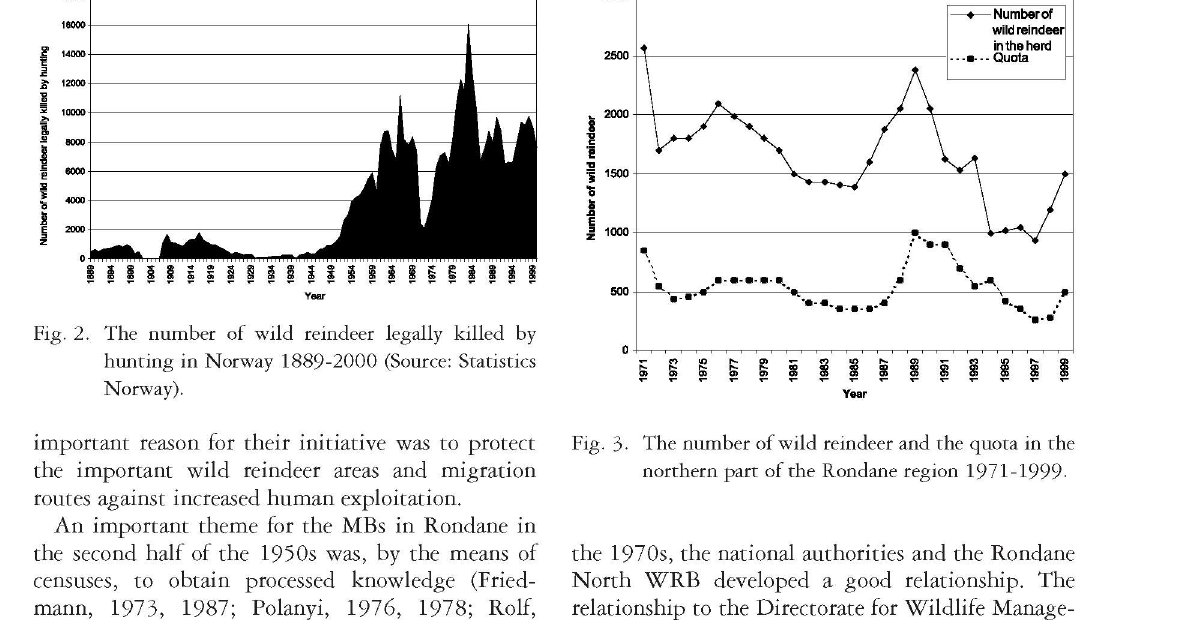
Fig. 3. The number of wild reindeer and the quota in the northern part of the Rondane region